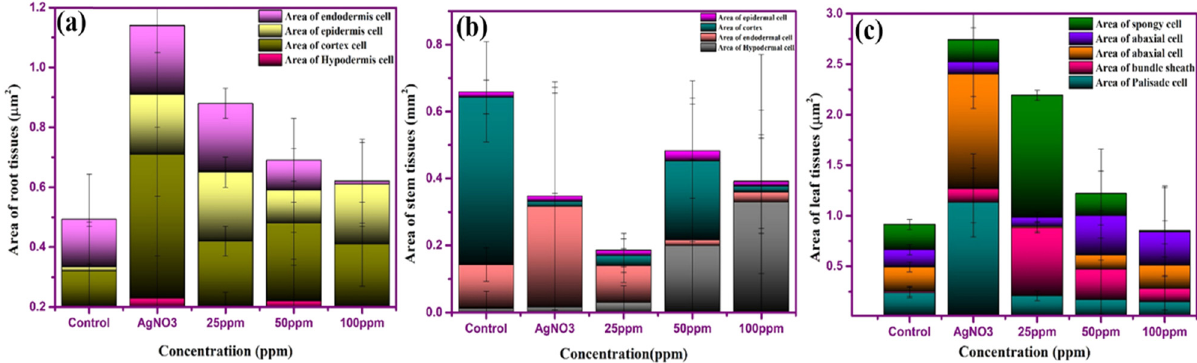
Figure 3: E ff ect of di ff erent concentrations of Ag NPs and AgNO 3 ( 1 M ) on area of endodermis, epidermis, cortex, and hypodermis cell: ( a ) root tissue, ( b ) stem tissue, and ( c ) area of spongy cell, abaxial, bundle sheath, and palisade cell in